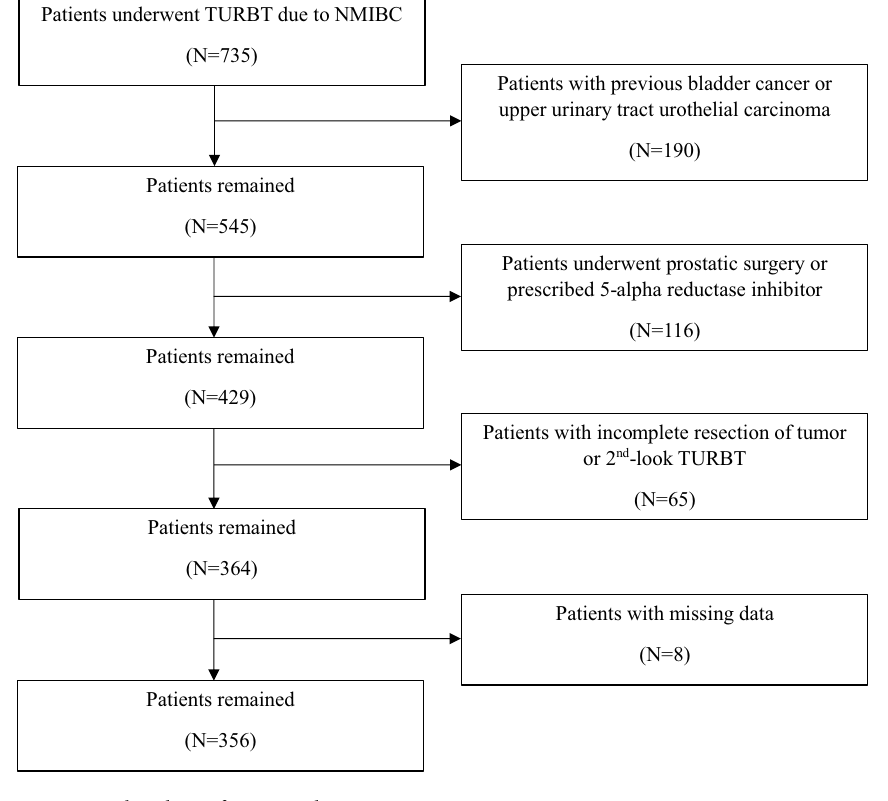
Figure 3. Flowchart of patient